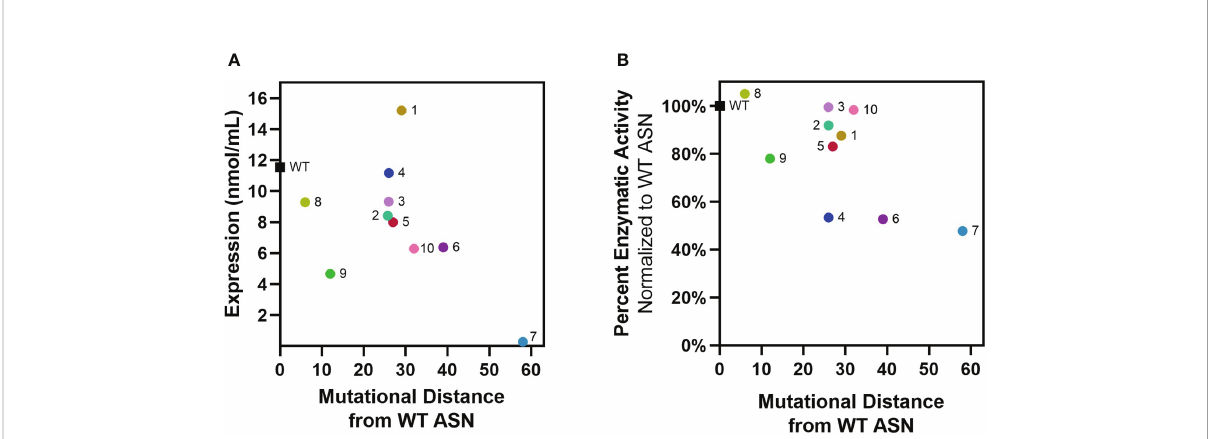
FIGURE 2 Re-surfaced ASNs express and maintain activity at high mutational loads. Re-surfaced ASN variants were expressed in E coli , with protein abundance and enzymatic activity quanti fi ed from bacterial lysates. (A) Recombinant ASN protein was measured via His-tag quanti fi cation, with expression compared to mutational distance from WT ASN. (B) Recombinant ASN enzymatic activity was measured via biochemical kinetic assay following binding to nickel-coated plates. Relative activity compared to WT ASN is shown and compared to mutational distance from WT ASN. All data points represent the mean values from 3-4 technical